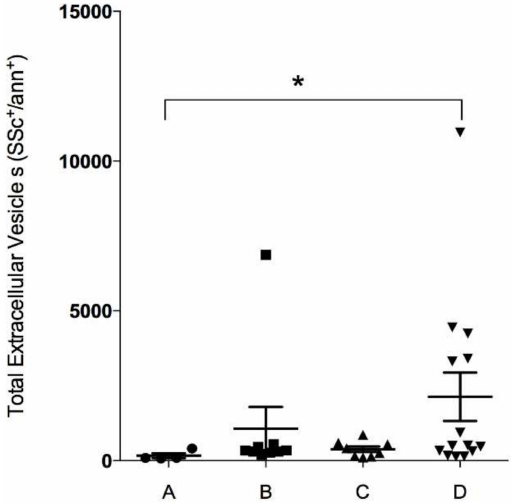
Figure 1. Flow cytometry analysis of total extracellular vesicles (EV) in plasma of chronic obstructive pulmonary disease (COPD) patients. Ordinary one-way ANOVA followed by Kruskal–Wallis multiple comparisons test (* p <